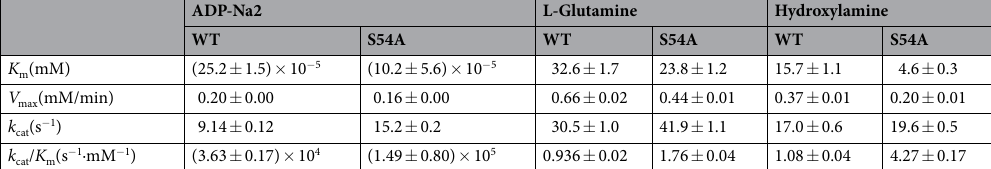
Table 1. Kinetic parameters of the wild type Pve GS and mutant S54A. Kinetic parameters of the wild type and mutant S54A. All the assays were carried out at the optimum pH and temperature for 30 min and data was given as mean values ±